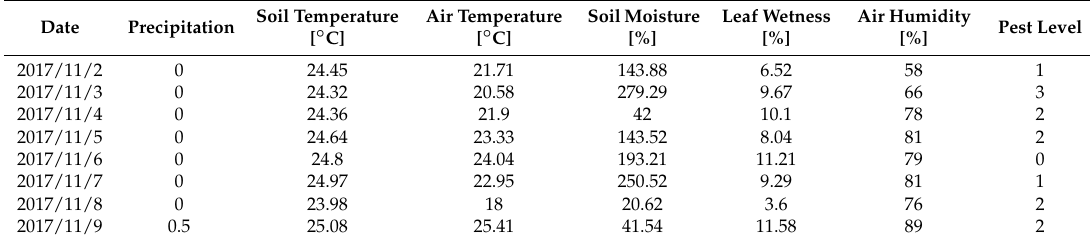
Table 2. Pest monitoring data.